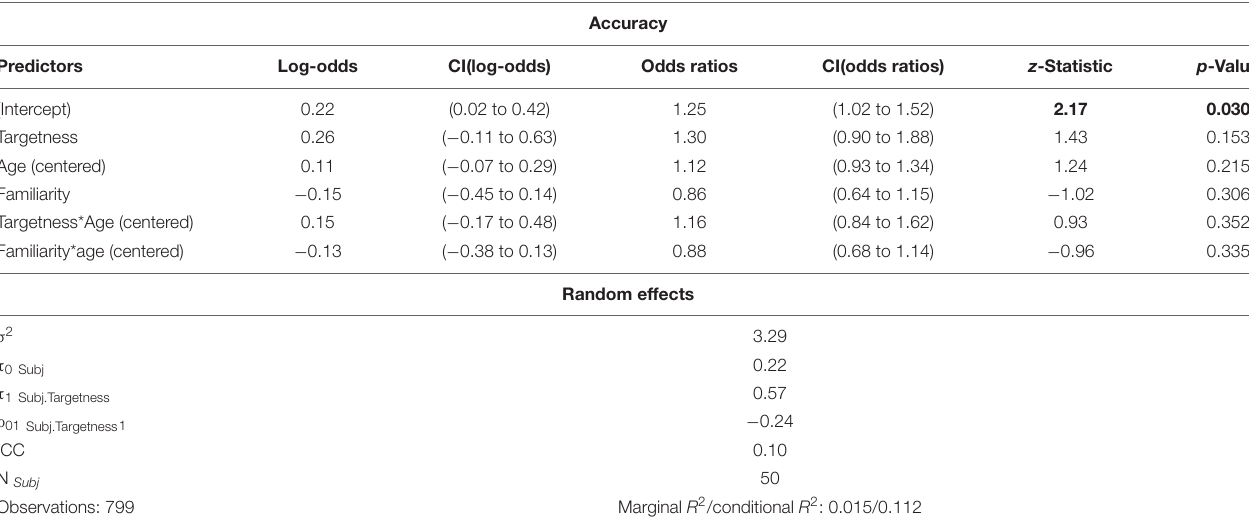
FIGURE 3 | Violin plots that represent the distribution of (A) the overall mean accuracy scores on the SC task, (B) the mean accuracy scores by Familiarity , and (C) the mean accuracy scores by Targetness . Error bars indicate SEs. The dots represent the individual scores and the black cross indicates the mean with its numerical value. TABLE 6 | Summary of the accuracy model for the SC task (799 observations, N =